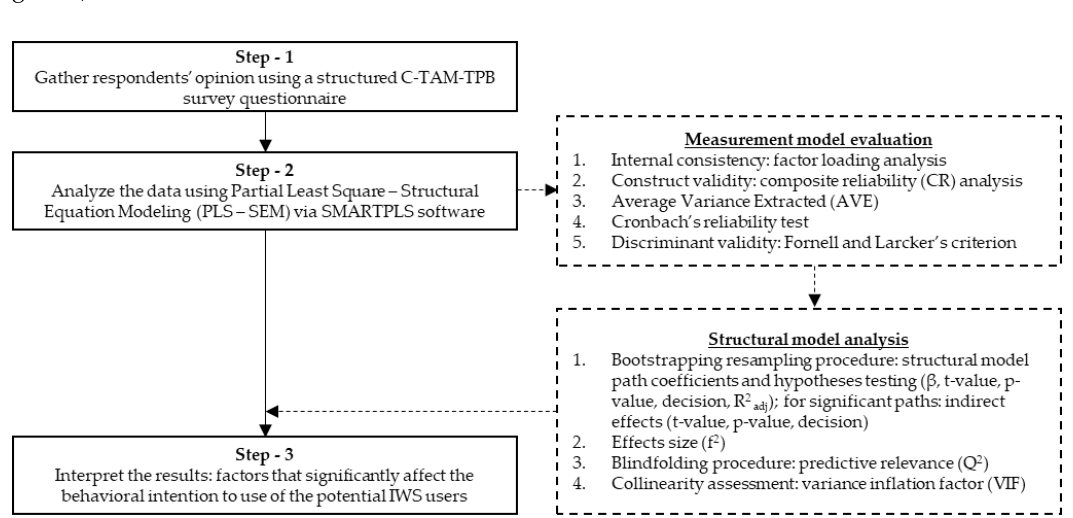
Figure 4. Flowchart of the C-TAM-TPB model data analysis.